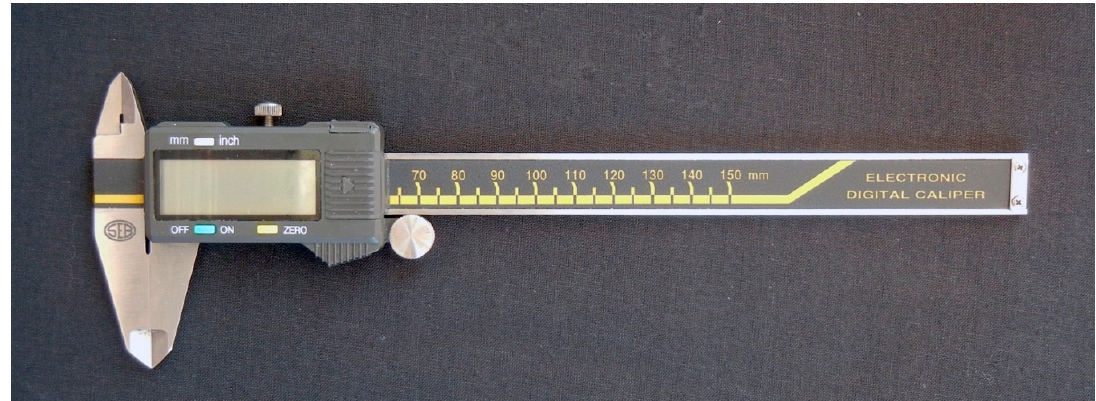
Figure 1. Digital Vernier caliper used to measure the displacement of the contact points.